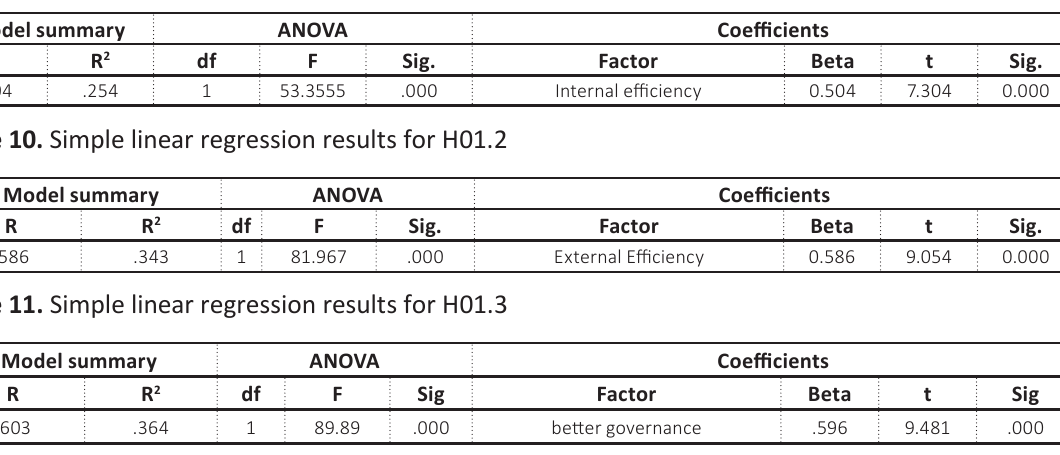
Table 9. Simple linear regression results for H01.1